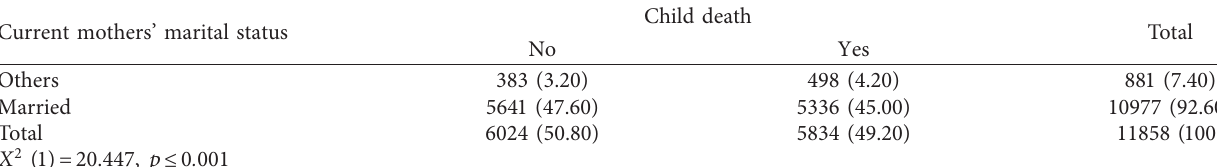
Table 7: Current mothers’ marital status on child mortality.